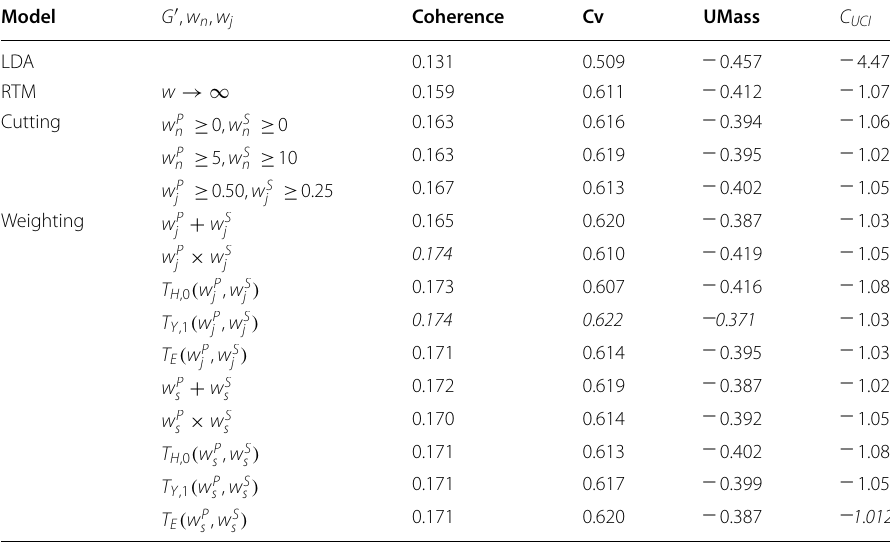
Table 3 Coherence, Cv, UMass, and C UCI scores of topics on G ′ against cutting and weighting